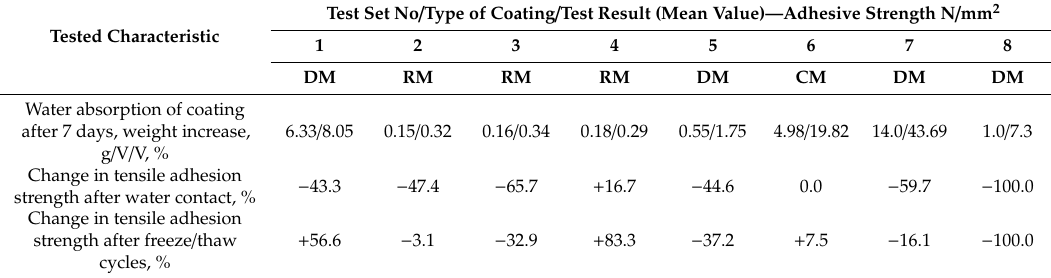
Table 5. Comparison of water absorption of waterproofing membranes with the values of tensile adhesion strength change obtained, following the exposure to ageing factors for eight coating sets. Tested Characteristic